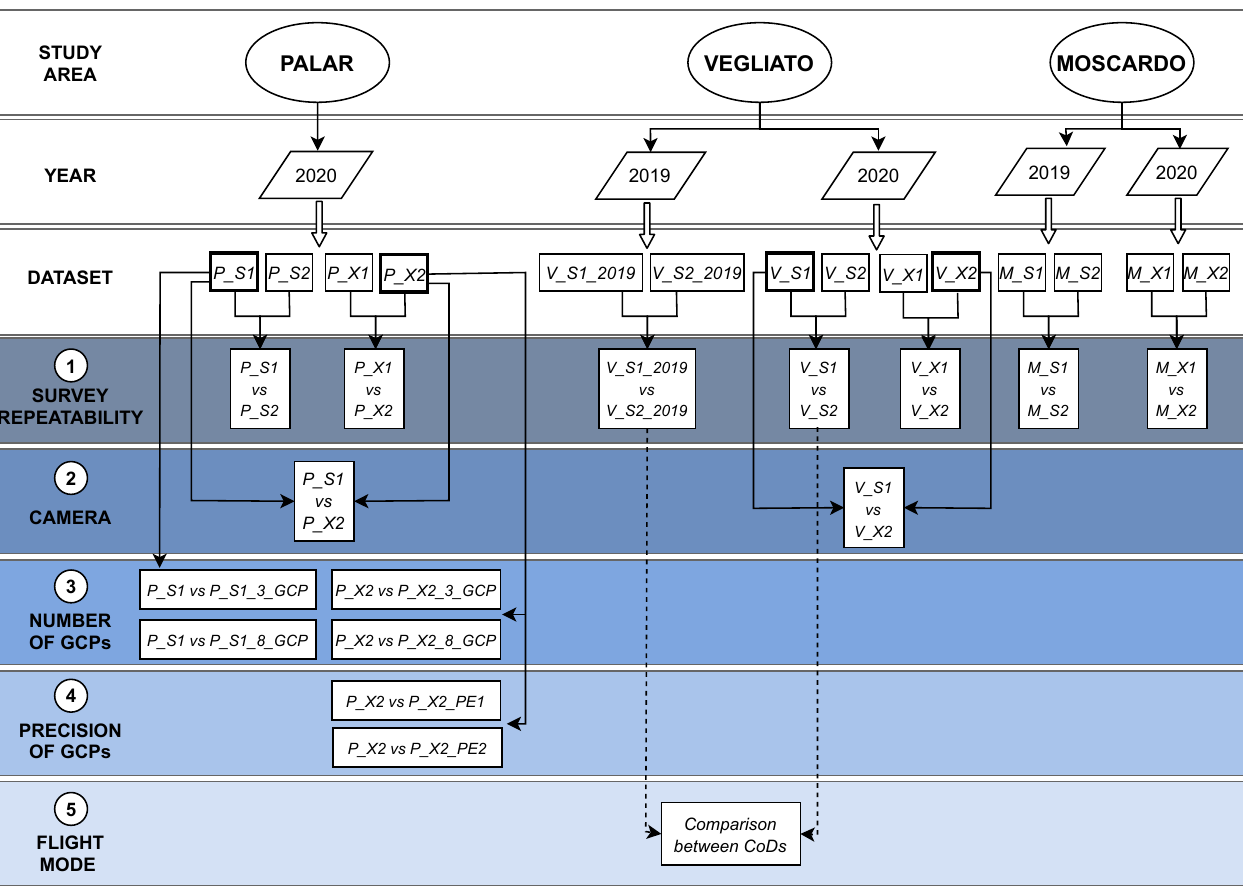
Figure 2. Comparisons performed for the three study areas between consecutive surveys to test survey repeatability (1), different cameras (2), various number of GCPs employed in the bundle adjustment (3), different 3D coordinate precision of GCPs (4) and two flight modes (5). The comparisons are labelled according to the names of the used datasets. The dataset characteristics are reported in Table